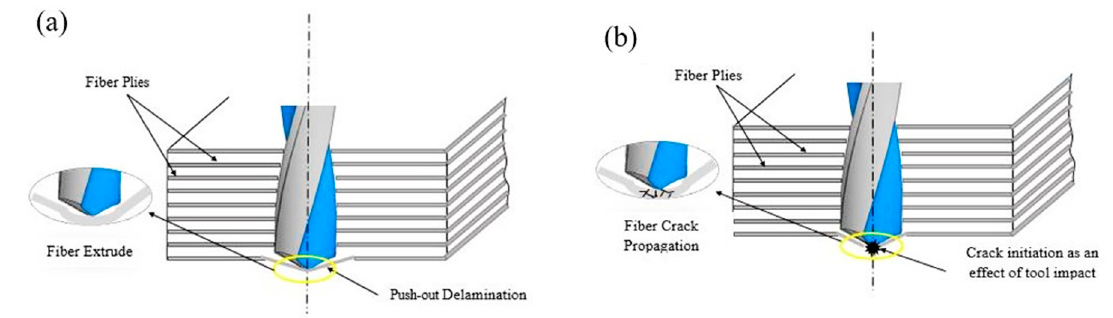
Figure 7. Effect of drilling technique on the carbon fiber-reinforced polymers (CFRP) fibers ( a ) CD ( b ) VAD.